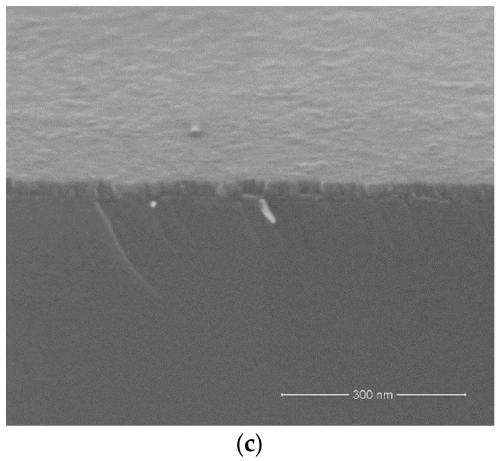
Figure 5. Cross-section SEM images at 300 k× magnification of TiO 2 film deposited at ( a ) Ar:O 2 = 30:1, ( b ) Ar:O 2 = 30:1.5 and ( c ) Ar:O 2 = 30:2 sccm flow rate.